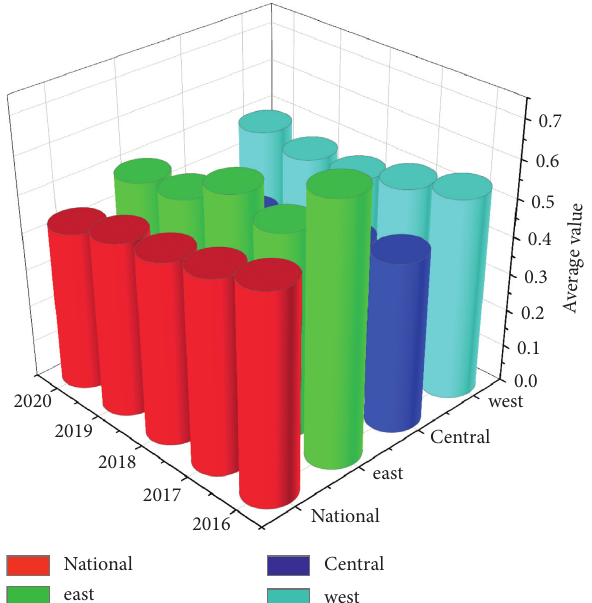
Figure 4: Comparison of the three major economic regions with the national average performance level in 2016–2020.